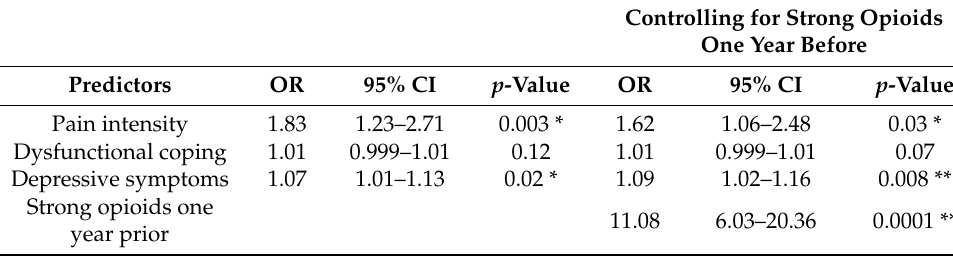
Controlling for Strong Opioids One Year Before